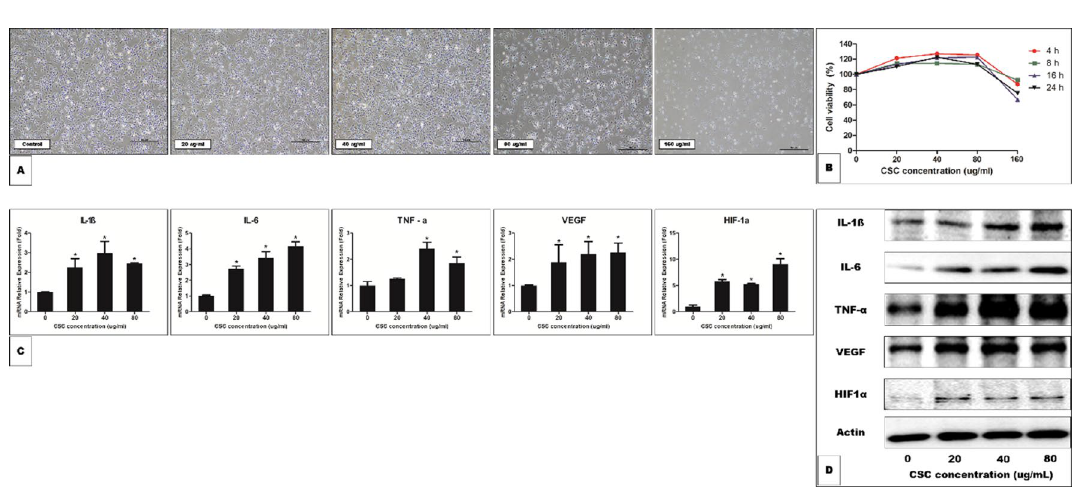
Figure 7. ( A ) Cell morphology of human middle ear epithelial cells (HMEECs) following exposure to cigarette smoke condensate (CSC) for 24 h. ( B ) The cell counting kit-8 assay reveals that cell viability decreases after the cells are exposed to 160 µg/mL CSC for 4, 8, 16, and 24 h. ( C ) Expressions of interleukin (IL)-1ß, IL-6, tumor necrosis factor (TNF)-α, vascular endothelial growth factor (VEGF), and hypoxia-inducible factor (HIF)-1α are upregulated by treatment with CSC. *P < 0.05. ( D ) The expression levels of IL-1ß, IL-6, TNF-α, VEGF, and HIF-1α are detected using western